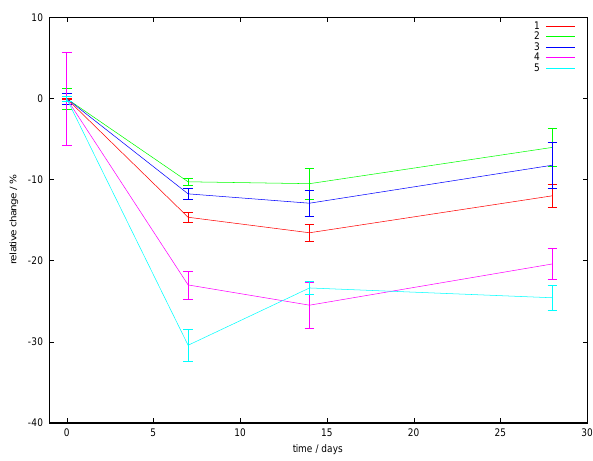
Fig. 6. Relative change of the five different fluorescence compo- nents as detailed in Tab. 2 vs. storage time for the untreated sample.